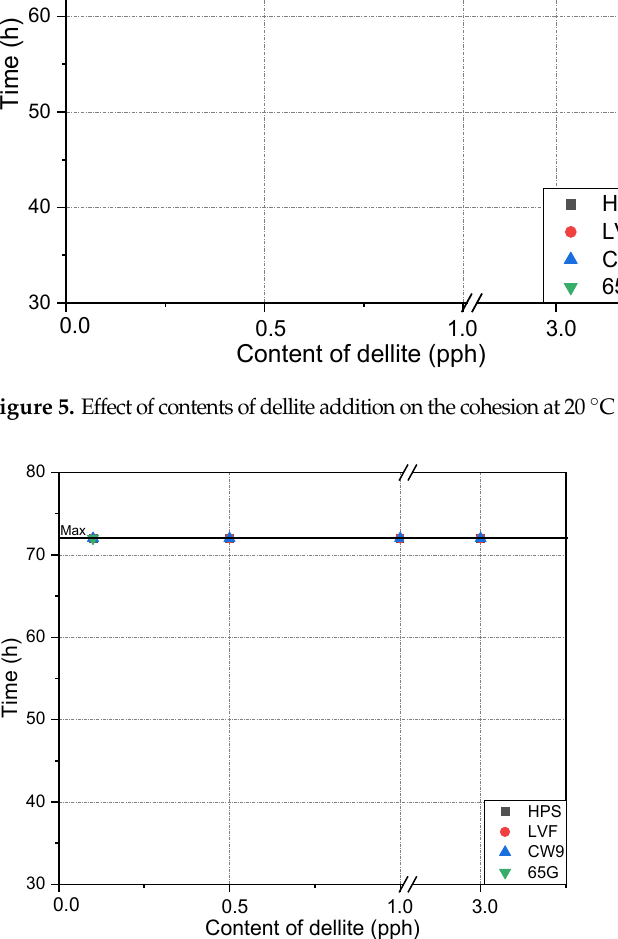
Figure 6. Effect of contents of dellite addition on the cohesion at 70 °C of silicone pressure-sensitive adhesives.